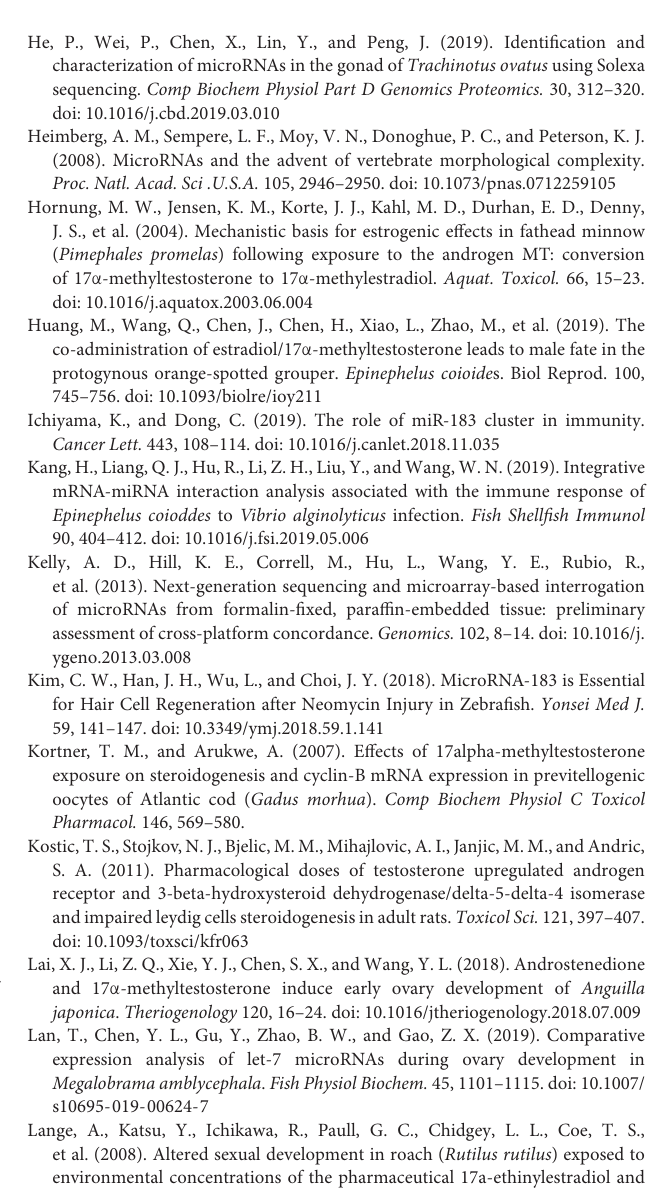
column represents a module, the number in the box is the correlation coefficient of the two modules, and the number in brackets is the p -value. The darker the square color is (red or green), the stronger the correlation is; the lighter the square color, the weaker the correlation. The p -value of the correlation between the two modules is calculated by student’s t -test. The smaller the p-value, the higher the similarity between the two modules. (b) Heat map drawn from clusters of the module genes. Each row and column represent a gene, and the darker the color of each point (white → yellow → red) represents the stronger connectivity between the two genes corresponding to the row and column. P -value was calculated by student’s t -test. The smaller the p -value, the more significant the correlation between the gene and the module. (c) The value of module eigenvalue in each sample reflects the comprehensive expression level of all genes in each sample. The abscissa is the sample, the ordinate is the module, and the characteristic value of the module is used for drawing. Red represents high expression and green represents low expression. The graph directly reflects the expression mode of each module in each